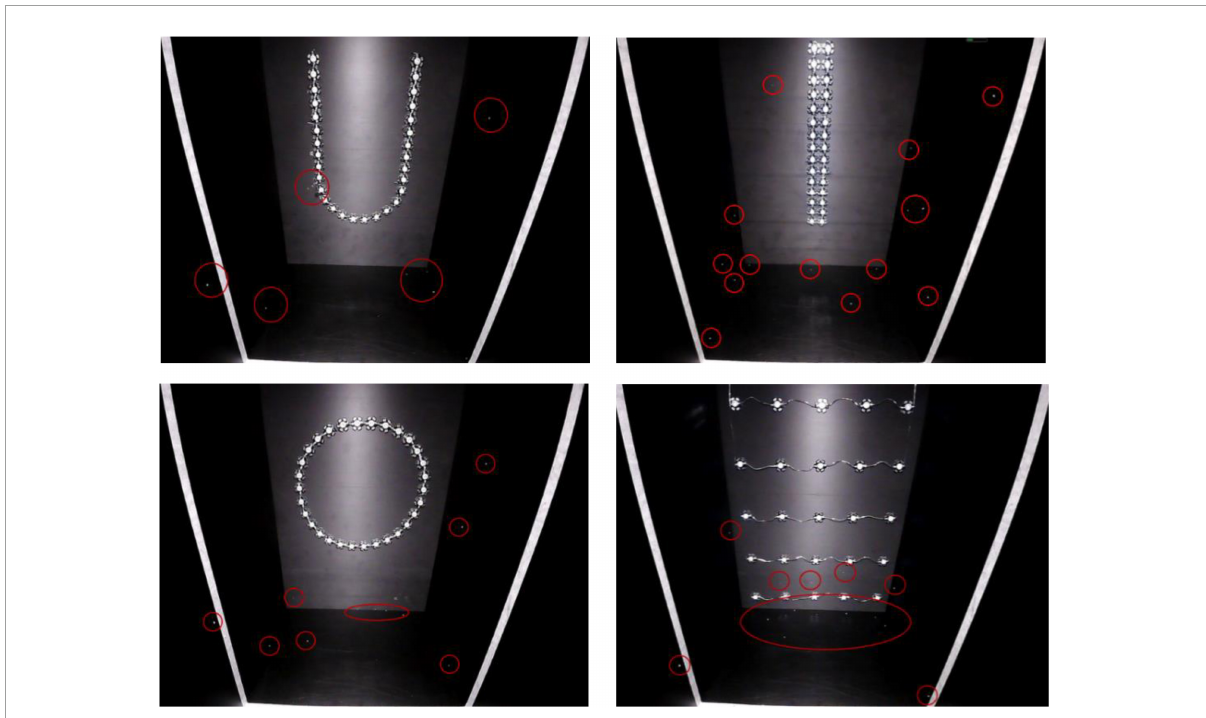
FIGURE11 Pictures of L. striatellus captured by the infrared camera under four different shapes of light source (the white lines in the figure represents a distance of 20 cm from a light source). The shapes are U-shaped in the upper left panel , linear in the upper right panel , circular in the lower left panel , and rectangular in the lower right panel